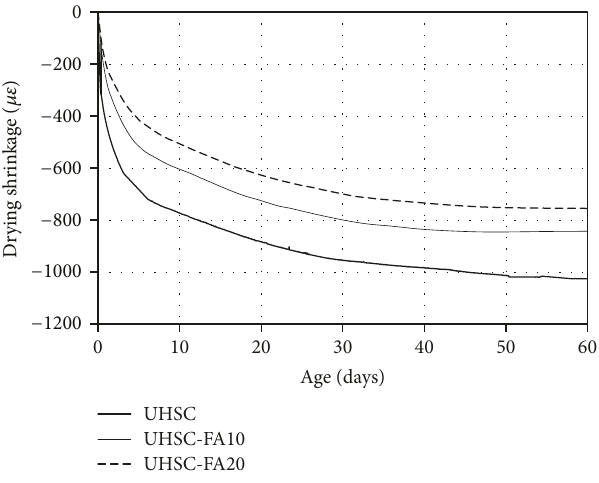
Figure 7: Drying shrinkage of UHSC with fly